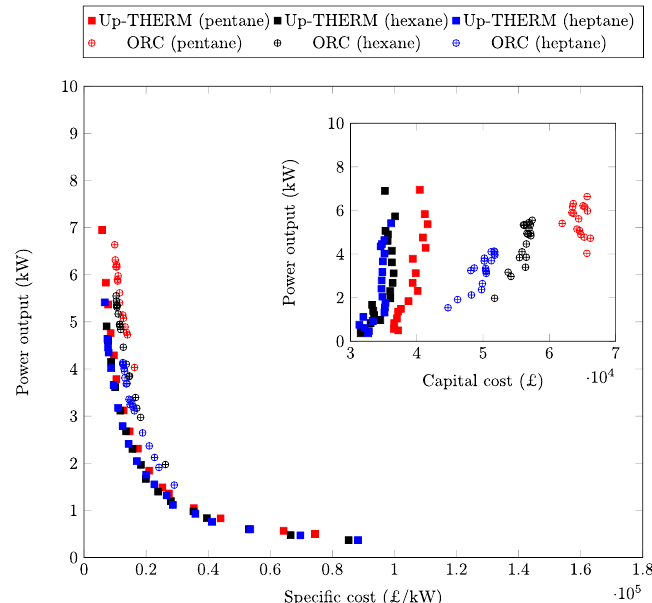
Figure 16. Capital cost (inset) and specific cost of the Up-THERM heat converter and ORC engines plotted over the respective power